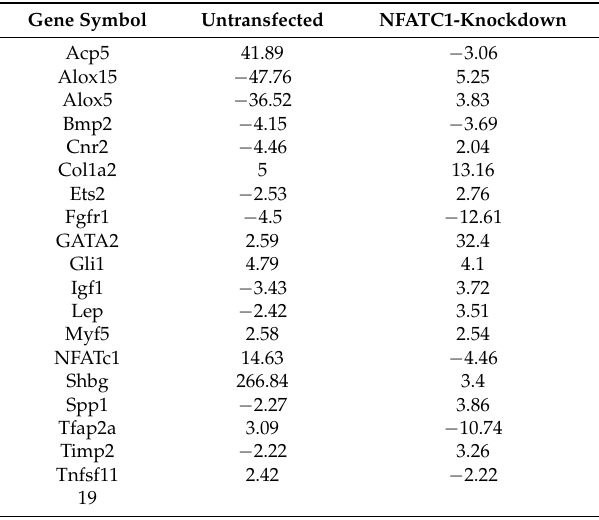
Table 3. List of common genes that changed ( ≥